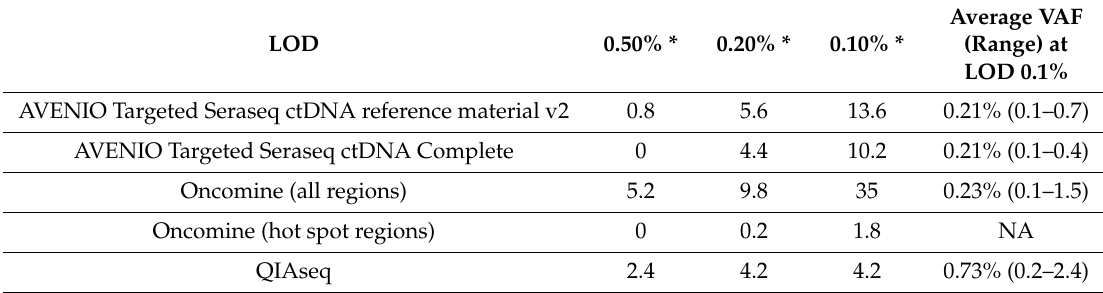
Figure 4. Accuracy rates of three NGS assays assessed with the Seraseq ctDNA Reference Material. ( A – D ) To assess the variant calling accuracy of the tested assays, we set 0.5%, 0.2%, and 0.1% thresholds for the limit of detection (LOD). Variants known to be present in the Seraseq ctDNA Reference Material v2 and called with a VAFs above the LOD were considered as true positives. Variants with VAFs higher than the LOD but not reported by SeraCare were considered as false positives. Shown are accuracy rates results for five di ff erent reference materials with various VAFs for ( A ) the Oncomine Lung cfDNA Assay (Oncomine) ( B ) a pre-filtered set of variants located in hotspot regions from the Oncomine Lung cfDNA Assay (Oncomine) ( C ) the AVENIO Targeted Kit (AVENIO), ( D ) the QIAseq Actionable Panel (QIAseq) ( E ) Accuracy of the AVENIO Targeted kit assessed with the Seraseq ctDNA Complete reference material. Table 1. False positive variant calls at various limits of detection